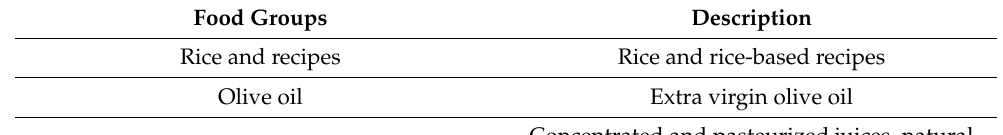
Table 2. Grouping of foods and recipes for the analysis of the dietary pattern of